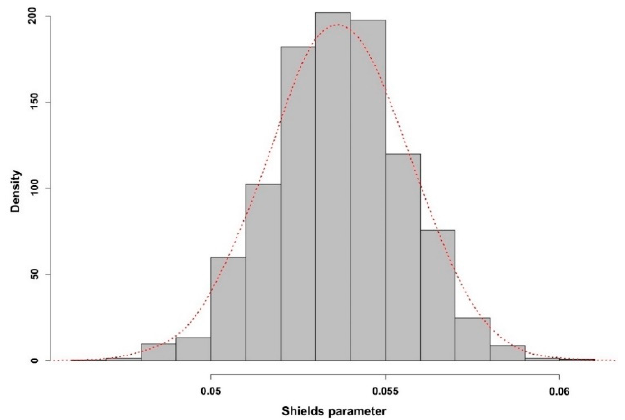
Figure 1. Example of the modeled Shields entrainment parameter θ distribution for coarse gravel ( 𝐷 (cid:2873)(cid:2868) = 27 mm). The red dotted line represents the fitted density line of the distribution and the y-axis (density) refers to the amount of modeled θ used for all 10,000 iterations to model 𝜏 (cid:3030) , 𝑘 (cid:3031) and subsequent ε .